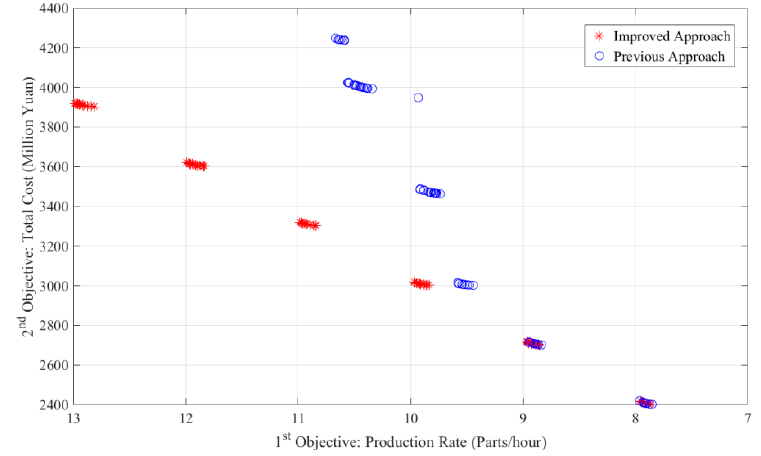
Figure 8. Comparison for Case A: results from the optimal sets of the additional runs. As shown in the figure: